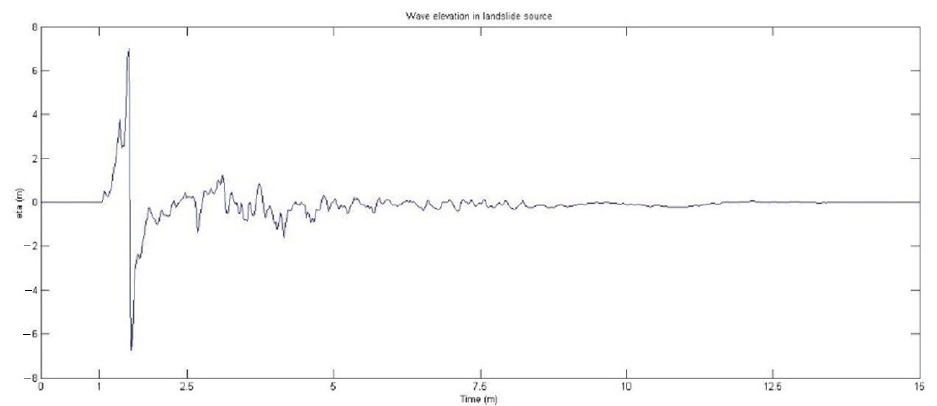
Figure 22. Free surface elevation obtained from the depth-integrated model in Monte Capo Pac ì (the landslide source).